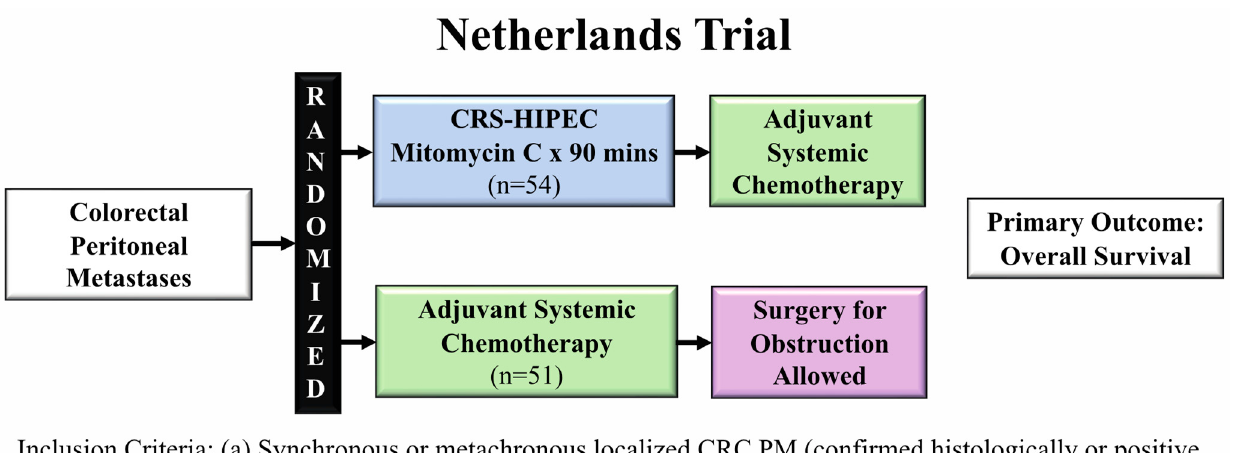
Figure 1. Netherlands trial schema comparing CRS-HIPEC to adjuvant systemic therapy evaluating overall survival.